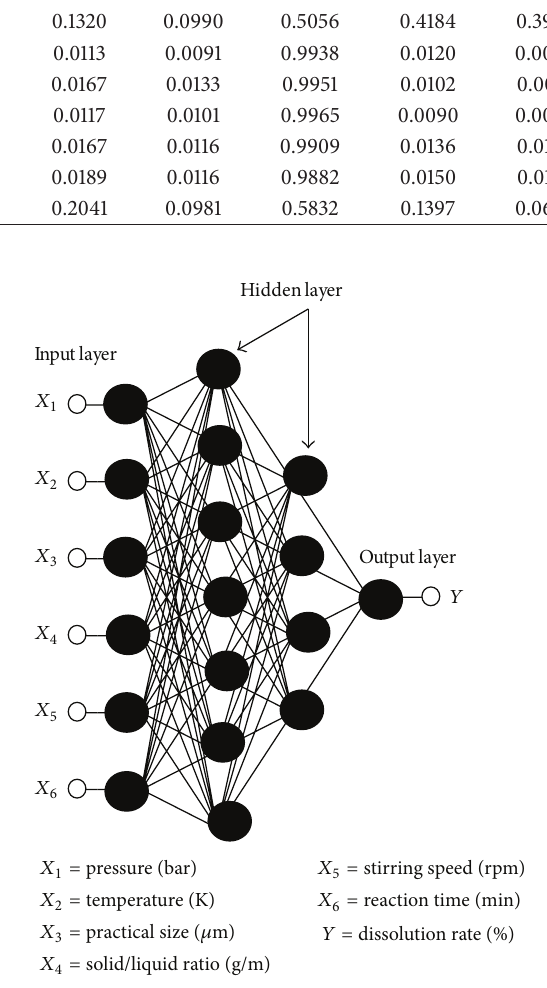
Figure 4: The optimum ANN model